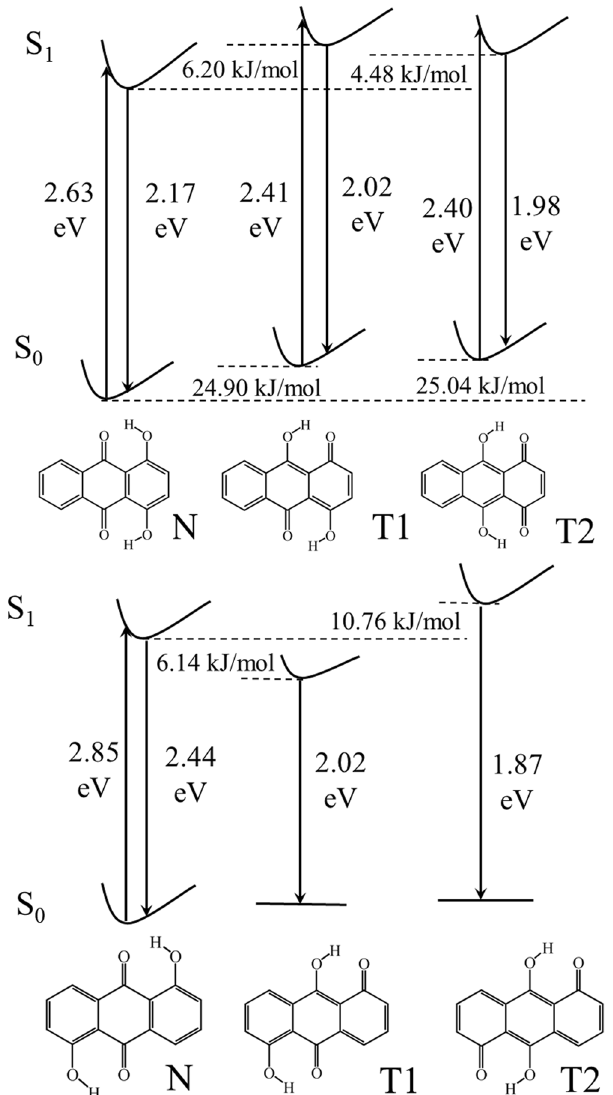
Figure 2. Stable structures of 1,4-DHAQ and 1,5-DHAQ in ground states and excited states for ESIPT